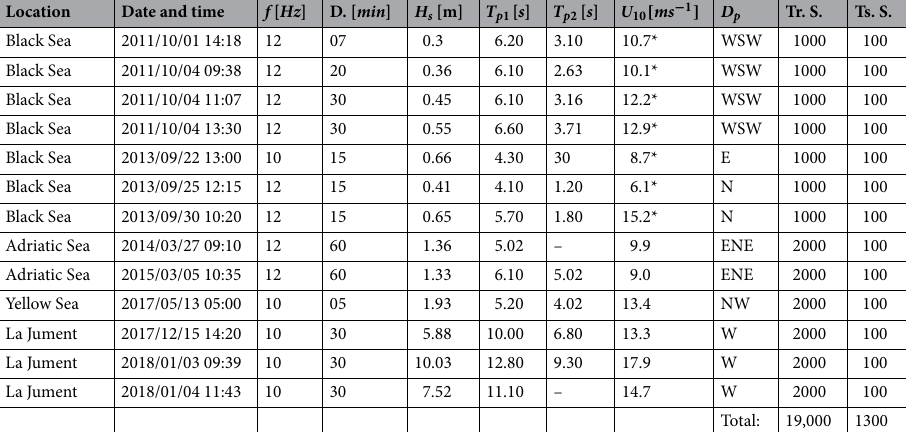
Table 1. Data characterization summary table. f is the sampling frequency in Hertz, D is the duration of the experiment in seconds, H s is the significant wave height computed from the wave spectrum, T p 1 and T p 2 are, respectively, the peak wave period of the first and second spectral partitions computed following Hanson and Jensen 50 , D p is the peak wave direction, and U 10 is the wind speed measured or converted (denoted by the ∗ ) to a height of 10 m above the sea surface using Large and Pond’s 51 formula. Tr. S. and Ts. S. are the sample size of the train and test datasets,